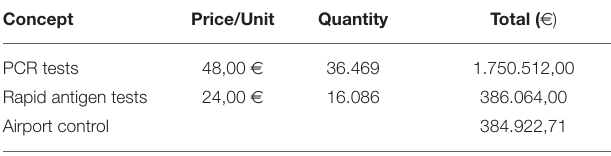
TABLE 7 | Costs of tests and airport